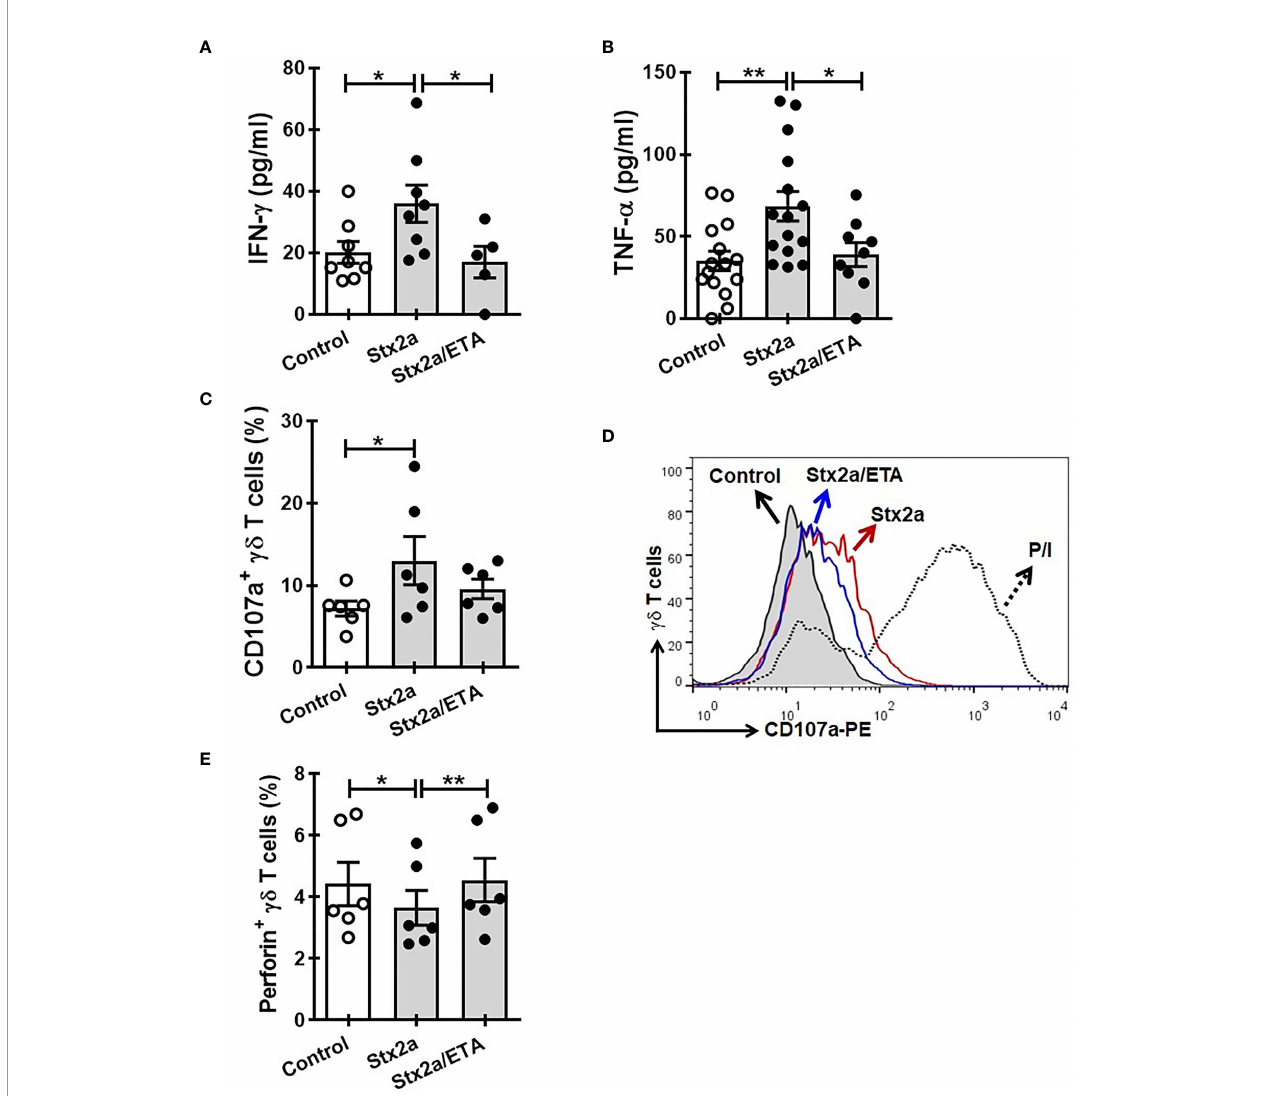
FIGURE 4 | Etanercept impedes the activation of gd T cells induced by Stx2a-treated HGEC. gd T cells were cultured overnight at 37°C with a conditioned media obtained from con fl uent monolayers of HGEC, treated (Stx2) or not (Control) with Stx2a (0.01 ng/ml, 24 h). One group of cells were pre-incubated with Etanercept (ETA: 25 µg/ml, 30 min at 37°C). After overnight incubation, supernatants and cells were collected. (A, B) IFN- g (n=5) and TNF- a (n=9) released to the medium determined by ELISA, respectively. Biological replicates. Kruskal-Wallis test, with Dunn ’ s multiple comparisons test. (C, D) Expression of CD107a in gd T cells, analyzed by fl ow cytometry. (C) Percentage of CD107+ gd T cells (n=6). Biological replicates. Kruskal-Wallis test, with Dunn ’ s multiple comparisons test. (D) Representative histogram of one experiment out of six performed. Gray histogram: gd T cells cultured with conditioned medium from Stx2a-non-treated HGEC (Control); histogram red: gd T cells cultured with conditioned medium from Stx2a-treated HGEC (Stx2a); histogram blue: gd T cells cultured in presence of Etanercept (ETA) and with conditioned medium from Stx2a-treated HGEC (Stx2a/ETA); dot line histogram: gd T cells incubated with PMA and ionomycin (P/I) (positive control). (E) Percentage of perforin+ gd T cells, analyzed by intracellular staining and fl ow cytometry (n=6). Biological replicates. Friedman test, witn Dunn ’ s multiple comparison test. Results are shown as the mean ± SEM. * p < 0.05 and ** p <